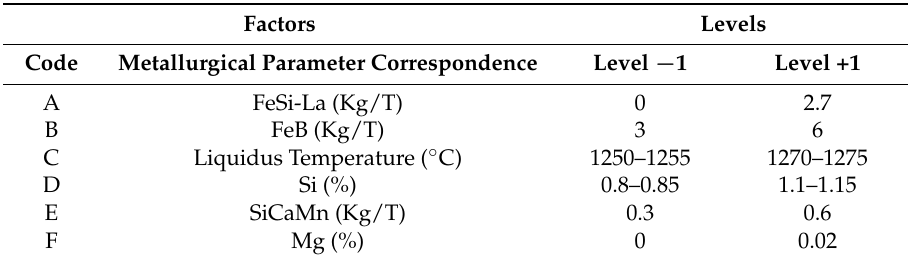
Table 2. Factors and Levels analyzed in the Design of Experiments (DOE).